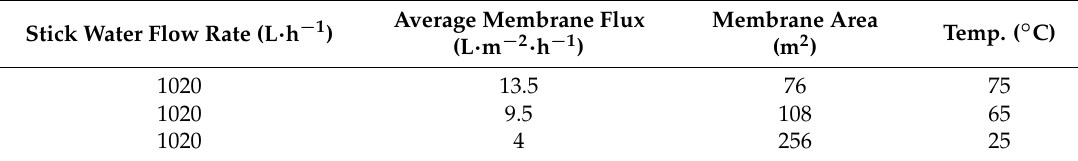
Table 1. Estimated minimum membrane